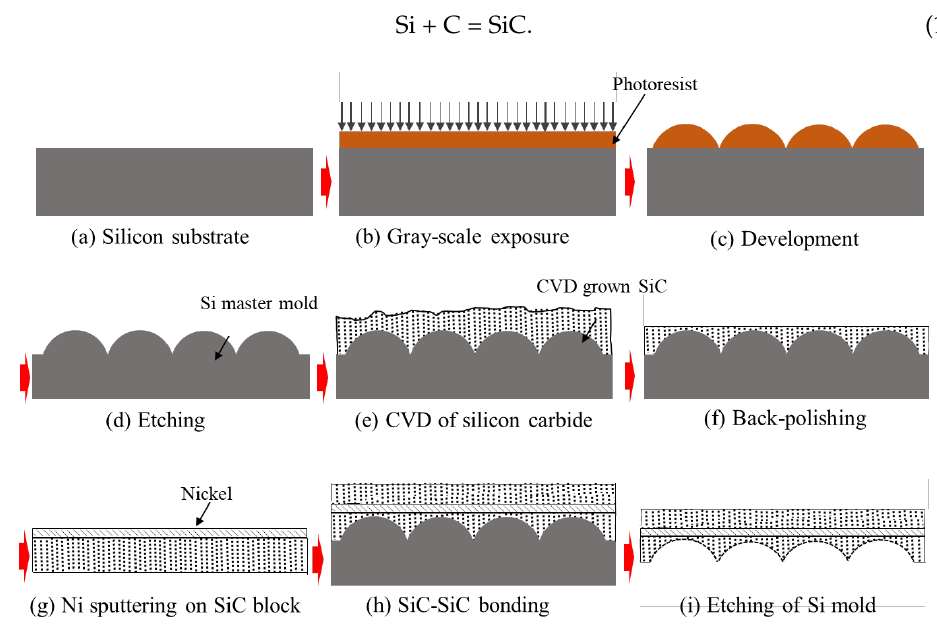
Figure 5. Schematic of SiC mold fabrication by Si lost molding: ( a ) Si substrate, ( b ) gray-scale lithography, ( c ) photoresist development, ( d ) etching, ( e ) deposition of SiC powder, ( f ) back polishing for smoothening, ( g ) sputtering of the Ni interlayer, ( h ) bonding with the SiC block, and ( i ) etching away of the Si substrate using a chemical solution.